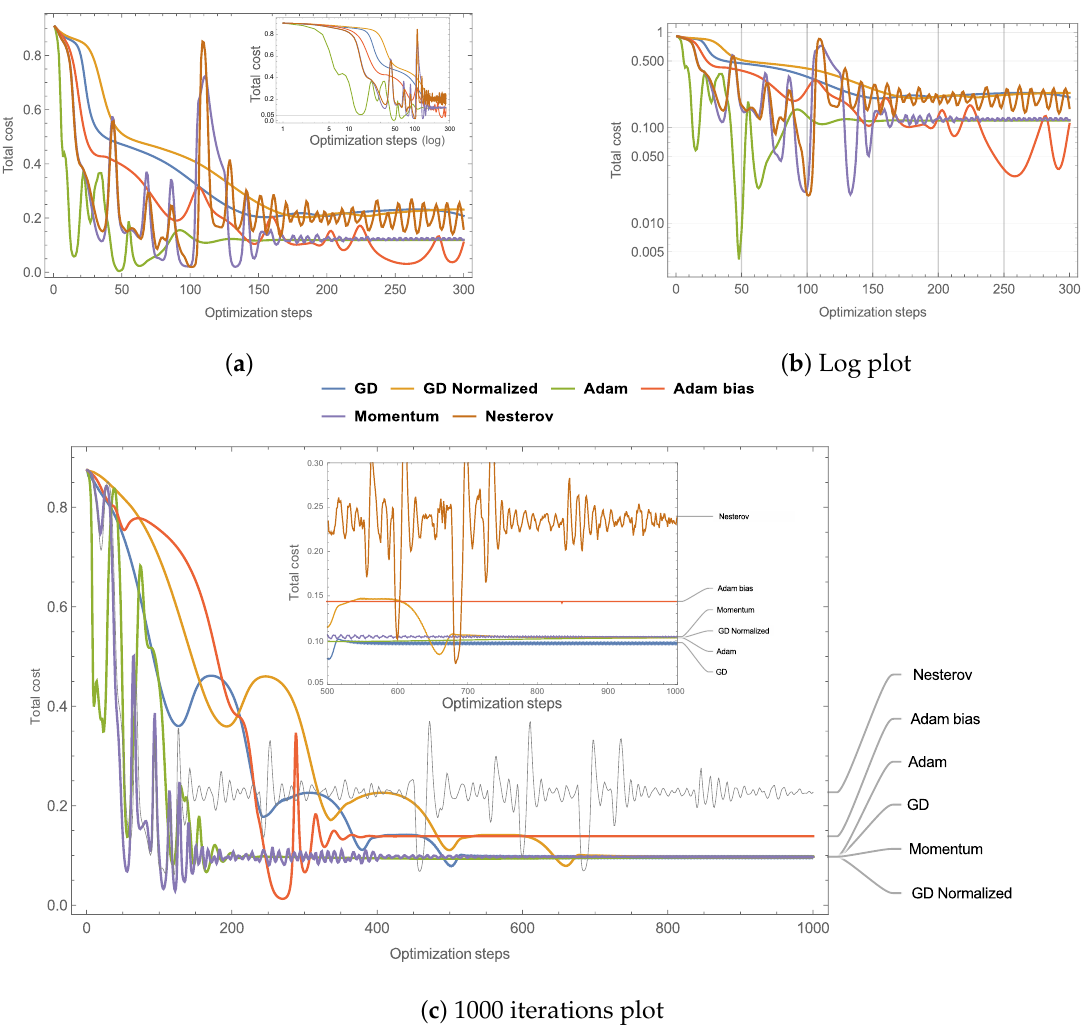
Figure 2. Panel ( a ) The linear plots of the total cost (running cost + final cost) for each optimization using several GD variants when T max = 0.85. Panel ( b ) the logarithmic plot. Adam variant shows the faster initial decay and also reaches the smaller minimum at roughly 50 steps. Panel ( c ) iterations up to 1000 steps. Table 1. Parameter selection for each optimization